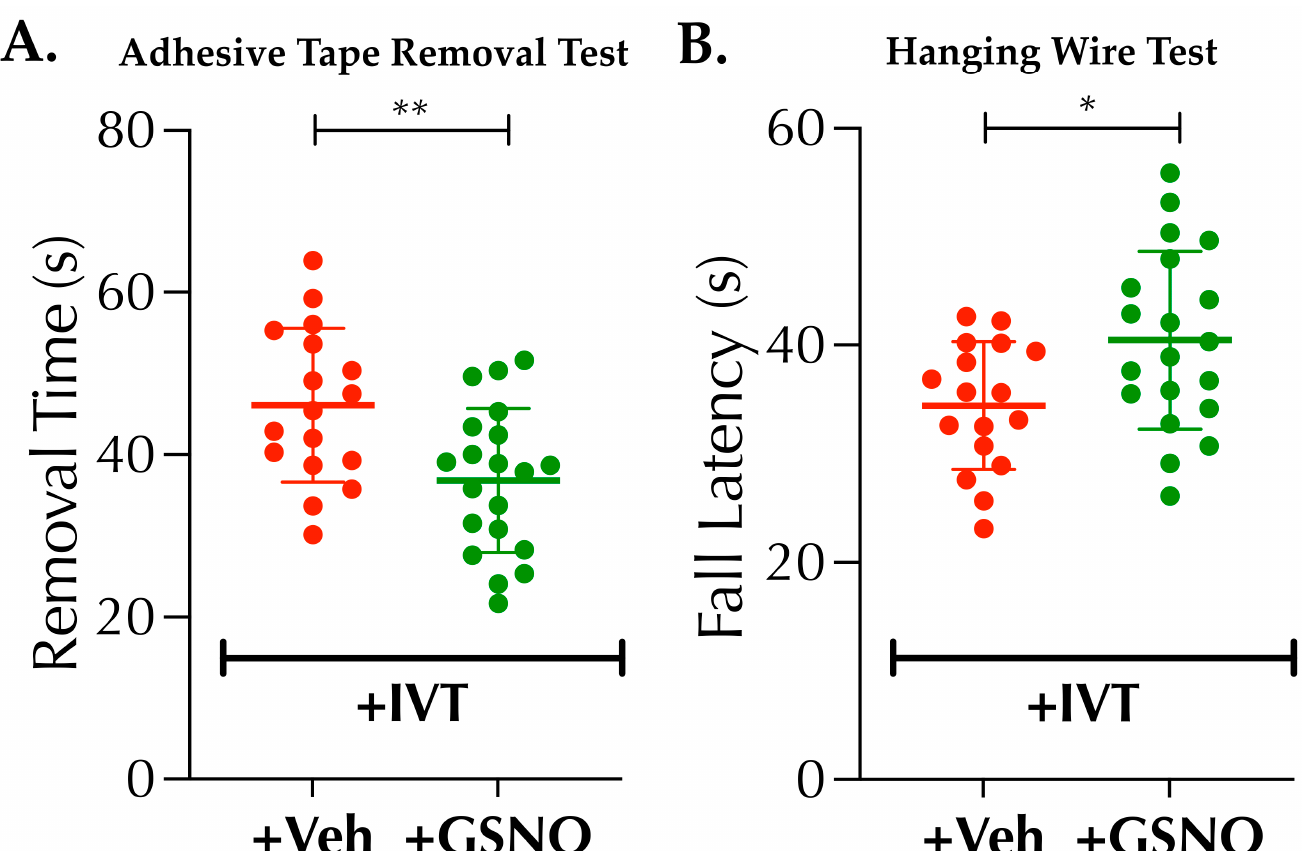
Figure 5. Nebulization of GSNO improves post-thrombolysis behavioral outcomes in diabetic mice subjected to thrombotic stroke. Diabetic male mice (C57/B6 background, 14 ± 1-wks. old) were subjected to PT-stroke and treated with either Veh or GSNO (100 µ g/kgbwt × 2 doses at 2 h and 6 h post-stroke) as described in Figure 1, followed by thrombolysis in all mice as mentioned in Figure 4. At 6 h post-stroke, mice ( n = 10 mice/group) were infused with the tracer dye, Evan’s blue (EB), for the assessment of BBB-leakage and integrity at 24 h post-stroke; and the remaining ( n = 10 mice/group) were left without EB-infusion for the estimation of hemoglobin (Hb) content as the marker of post-thrombolysis HT at 24 h post-stroke. All mice from above 2 experiments for EB- and HT-contents were subjected to both, adhesive tape test (ATT) for somatosensory functional outcomes and hanging wire test (HWT) for muscular strength and coordination, prior to sacrifice at 24 h post-stroke. ( A ) GSNO-therapy in combination with late-IVT (GSNO + IVT group) significantly improved the somatosensory functions as compared to late-IVT alone (Veh + IVT) controls (**, p = 0.0042). ( B ) GSNO-therapy in combination with IVT-therapy (GSNO + IVT group) also significantly augmented the muscular strength, coordination and use functions as compared to Veh + IVT controls (*, p = 0.0164). Data are presented as Mean ± SD ( n = 17–20 mice/group). Statistical significance was determined at p < 0.05 and using an unpaired t-test. Following behavioral outcome measures,